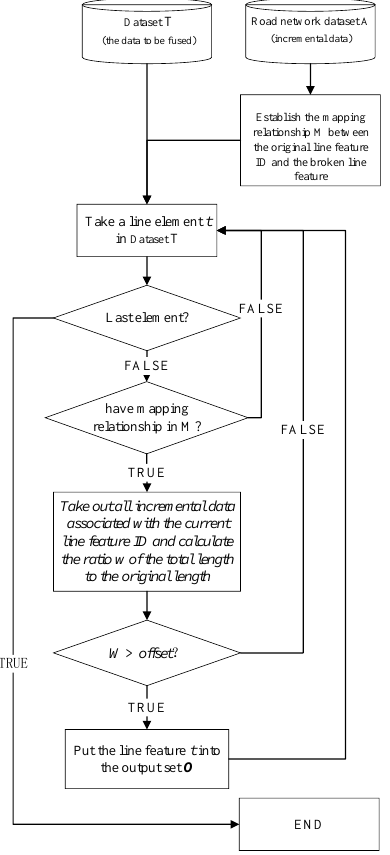
Figure 3. Work flow of the dataset fusion